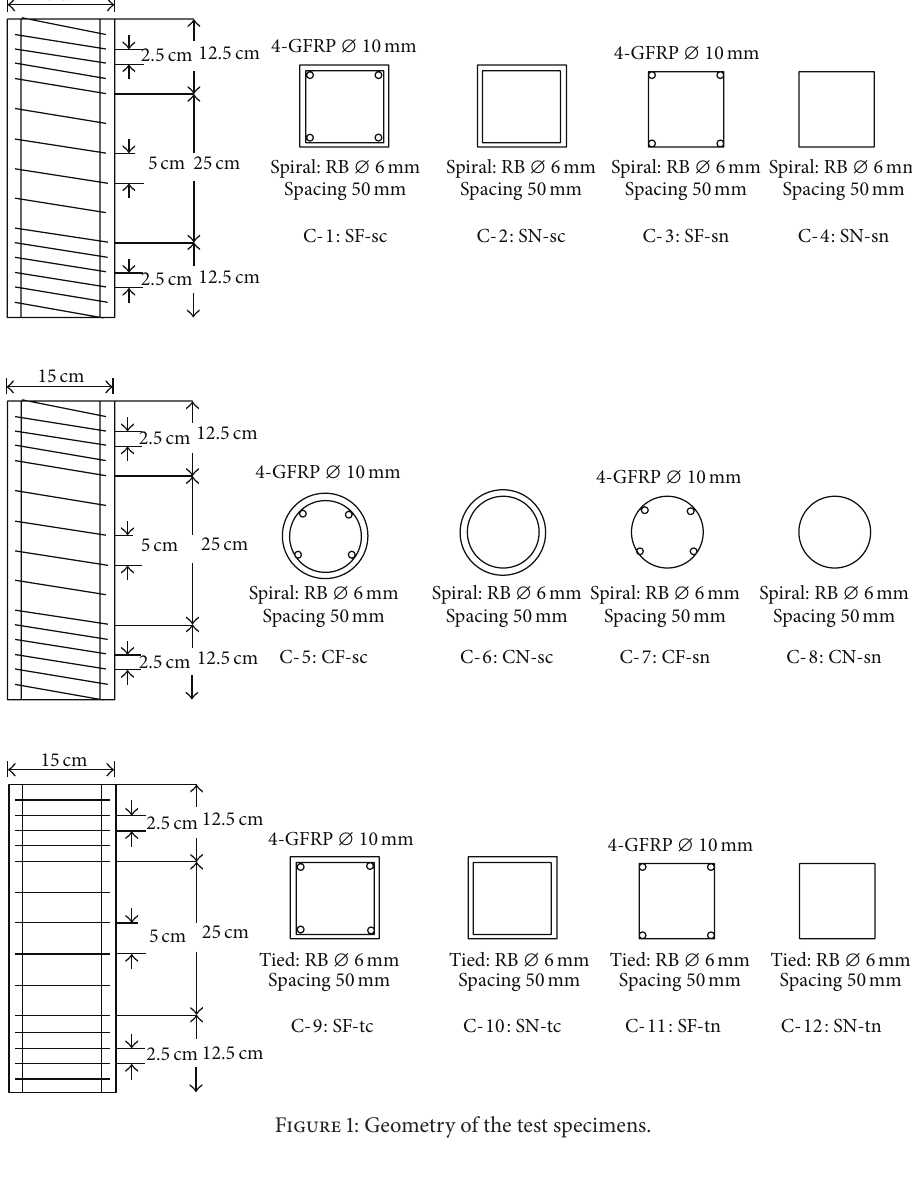
Figure 1: Geometry of the test specimens.